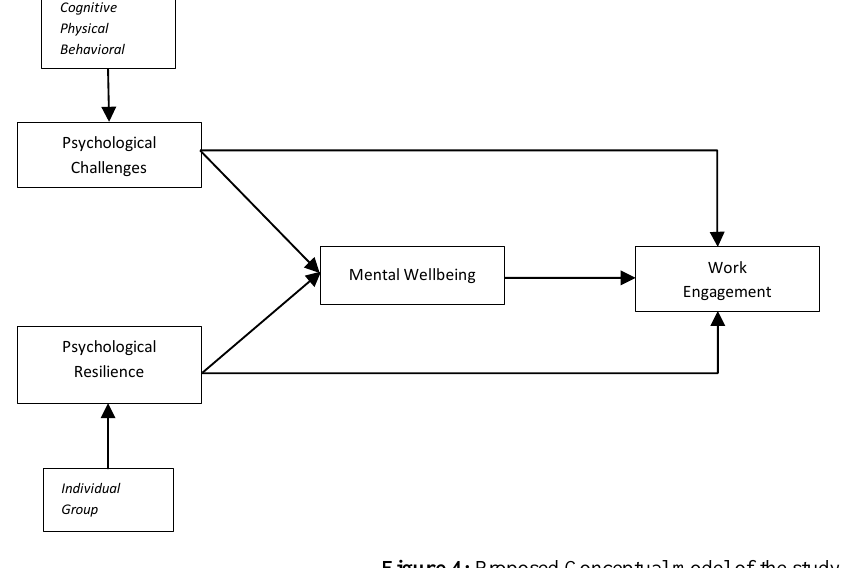
Figure 4: Proposed Conceptual model of the